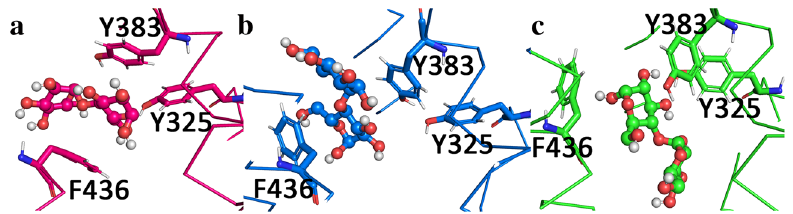
Figure 8. Maltose binding pocket with maltose bound, surrounded by key residues. ( a ) Maltose binding pocket in the ATP state, maltose is represented in sticks and spheres, while the residues are portrayed in sticks only. ( b ) Maltose binding pocket in the ADP state, maltose is represented in sticks and spheres, while the residues are portrayed in sticks only. ( c ) Maltose binding pocket in the Apo state, represented in blue and green, respectively. The relevant aminoacids are represented in sticks, while maltose is represented in spheres and